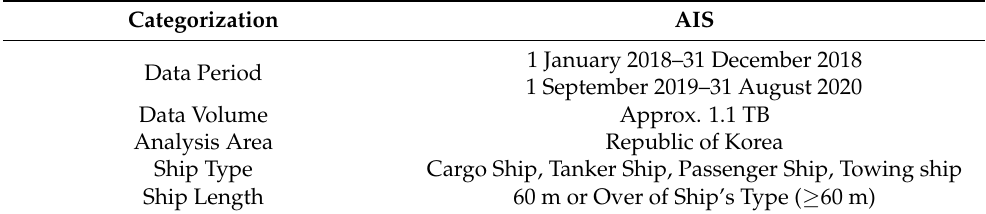
Table 2. AIS data characteristics.